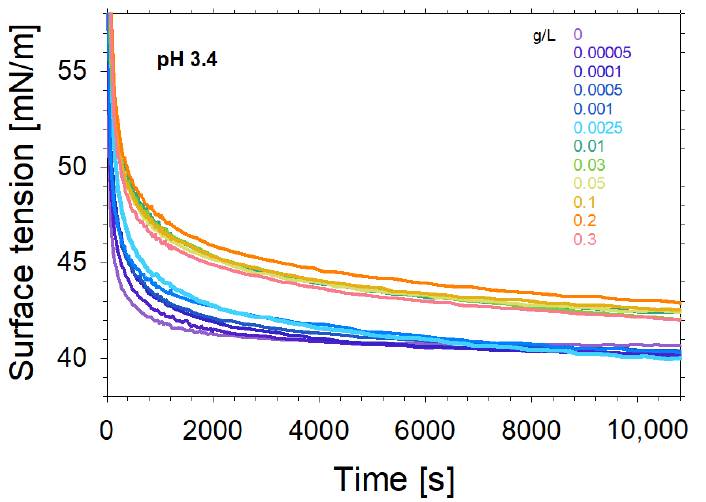
Figure 4. The dynamic surface tension of saponin solutions and saponin–chitosan mixtures in the presence of 0.1 wt% acetic acid and a solution pH of 3.4. The Saponin concentration was fixed at 0.1 g/L, while the chitosan concentration was varied from 0.0005 to 0.3 g/L as indicated in the figure.